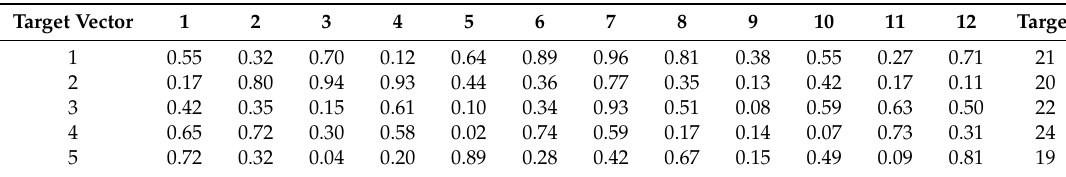
Table 11. Target vectors of round 1.